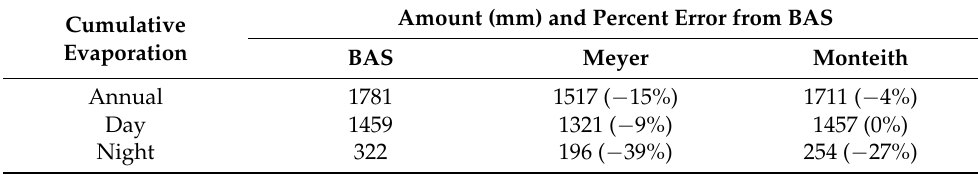
Table 5. Comparative summary of predicted evaporation for the study